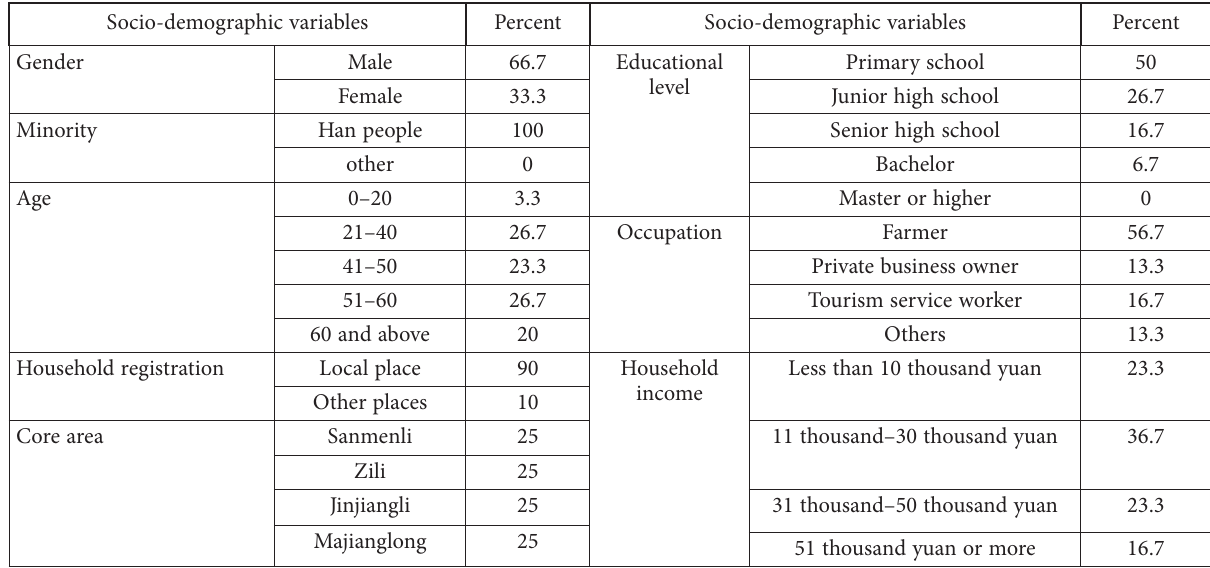
Table 4. Description of respondents (source: field survey) Socio-demographic